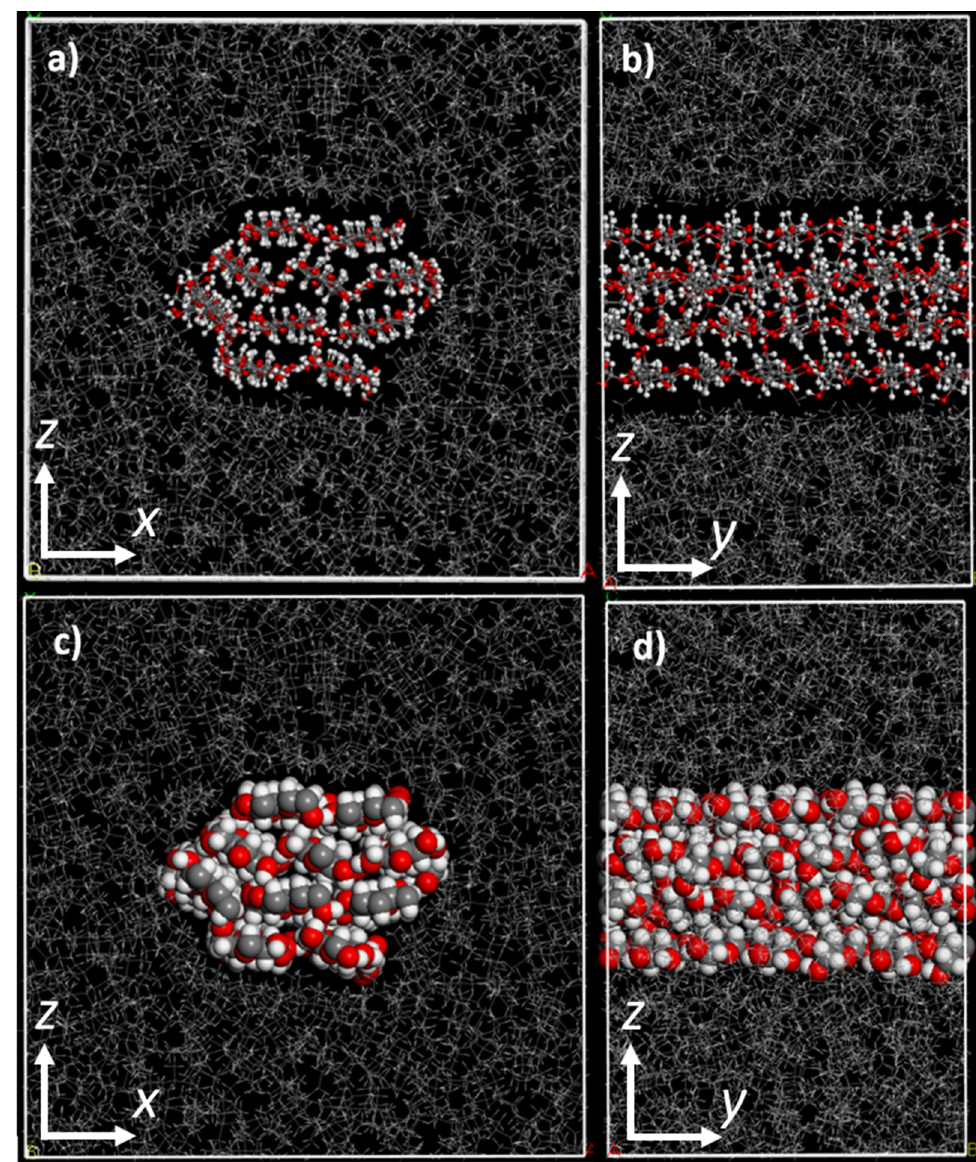
Figure 4. The final structure model of 20 m-% cellulose–PP composite presented in ball-stick (top) and space-filling (bottom) models. ( a , c ) show the front view and ( b , d ) show the side view of the periodical cellulose fibril. The dimensions of the simulation box are a : 5.01 nm, b : 3.25 nm, c : 5.01 nm. The fibril with diameter of 2.42 nm has 10 chains of cellulose and is surrounded by syndiotactic PP chains of 50 monomers.